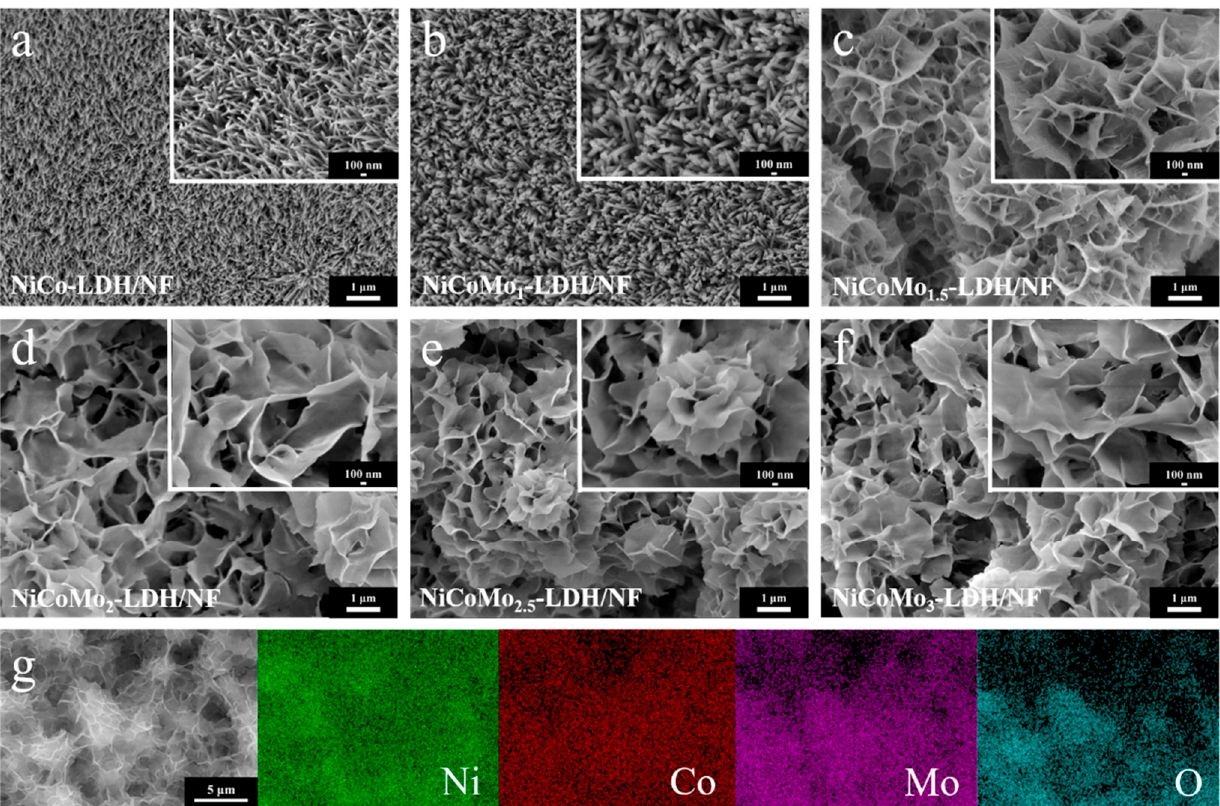
Figure 4. Low magnification and high magnification inset SEM images of ( a – f ) NiCo-LDH/NF, NiCoMo 1 -LDH/NF, NiCoMo 1.5 -LDH/NF, NiCoMo 2 -LDH/NF, NiCoMo 2.5 -LDH/NF and NiCoMo 3 -LDH/NF, respectively, and ( g ) EDS of NiCoMo 2 -LDH/NF nanosheets. The structure of the NiCoMo 2 -LDH/NF nanosheets was further confirmed by the TEM analysis (Figure 5a). As shown in Figure 5a, the NiCoMo 2 -LDH/NF nanosheets can be observed clearly. The high-resolution TEM (HRTEM) image (Figure 5b) shows various kinds of lattice fringes with distances of 0.216, 0.244, 0.262 and 0.267 nm corresponding to the (222), (400) and (222) planes of CoMoO 4 and (100) planes of Ni(OH) 2 , respectively. As shown in Figure 5c, the selected area electron diffraction (SAED) pattern shows (100) and (110) planes for Ni(OH) 2 , and (222) planes for CoMoO 4, indexed according to the reported X-ray diffraction (XRD) data.